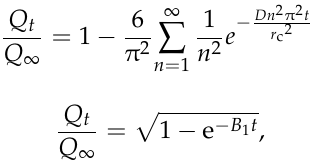
Table 4. Gas diffusion coefficients for supercritical CO 2 -treated and untreated tectonic and intact coals. Intact Coal Tectonic Coal Samples Untreated Treated Change Untreated Treated Change 2.6360 3.8480 D ( × 10 − 12 m 2 /s)